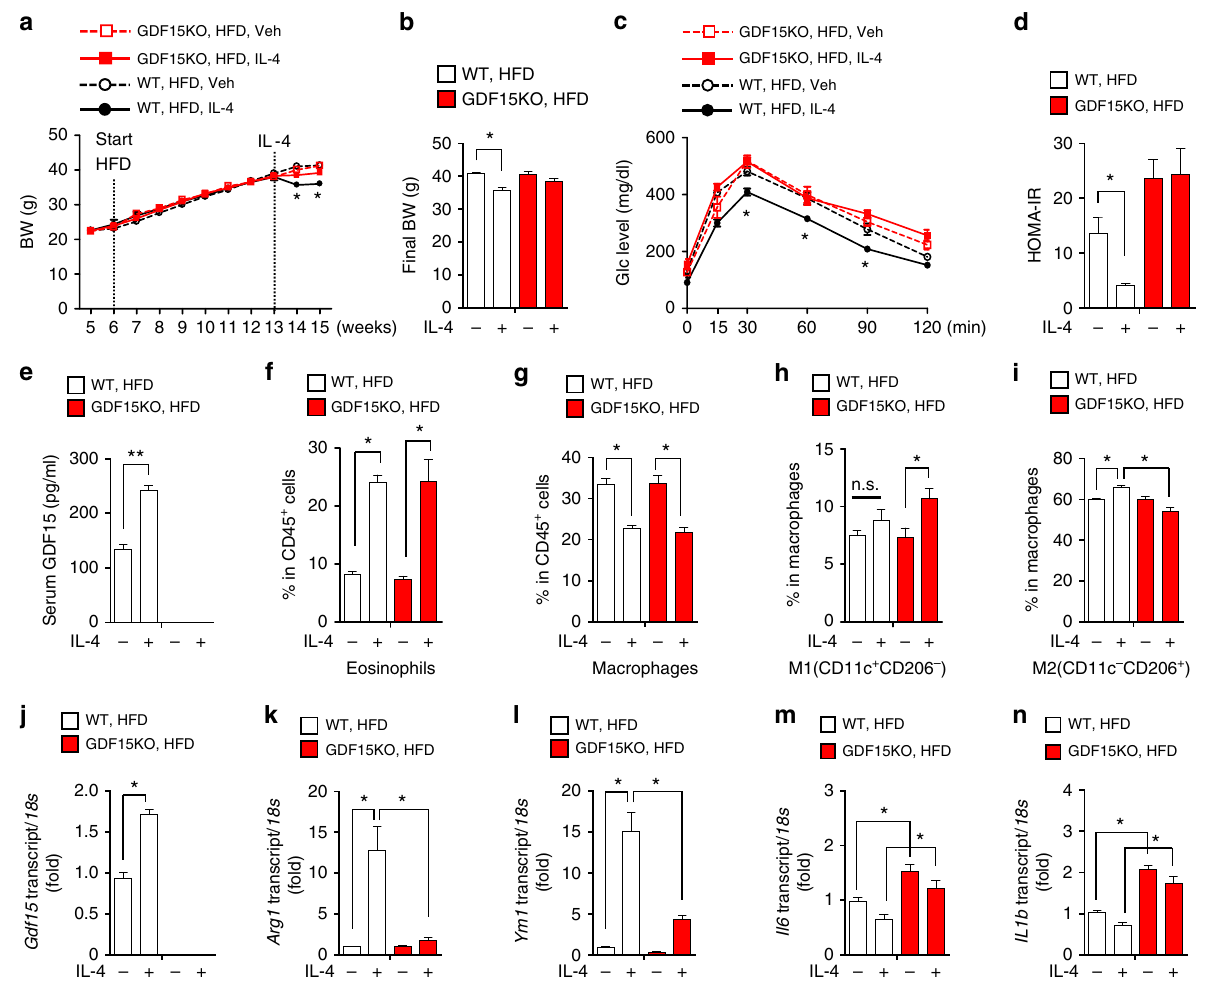
Fig. 6 GDF15 de fi ciency prevents improvement of insulin sensitivity by rIL-4. a , b Body weight of WT and Gdf15 -KO mice fed a HFD for 7 weeks and then intraperitoneally injected with rIL-4 (50 μ g/kg) for 2 weeks ( n = 5 per group). c WT or Gdf15 -KO mice fed a HFD after injection of IL-4 were subjected to an IPGTT after a 16 h fast. d HOMA-IR of HFD-fed WT and Gdf15 -KO mice after treatment with rIL-4. e Serum GDF15 level of HFD-fed WT and Gdf15 -KO mice after treatment with rIL-4. f – i FACS analysis of eosinophils (CD45 + /CD11b + /SiglecF + ), macrophages (CD45 + /F4/80 + /CD11b + ), and M1 (CD11c + /CD206 − ) and M2 (CD11c − /CD206 + ) macrophages in fi ltrated into eWAT. j Real-time PCR analysis of Gdf15 mRNA in CD11b + cells from eWAT of WT and Gdf15 -KO mice treated with rIL-4. k – n Real-time PCR analysis of Arg1 , Ym1 , Il6 , and Il1b mRNAs in CD11b + cells from eWAT of WT and Gdf15 -KO mice treated with rIL-4. Data are expressed as means ± SEM and are representative of three independent experiments. * p < 0.05 (two-tailed Student ’ s t